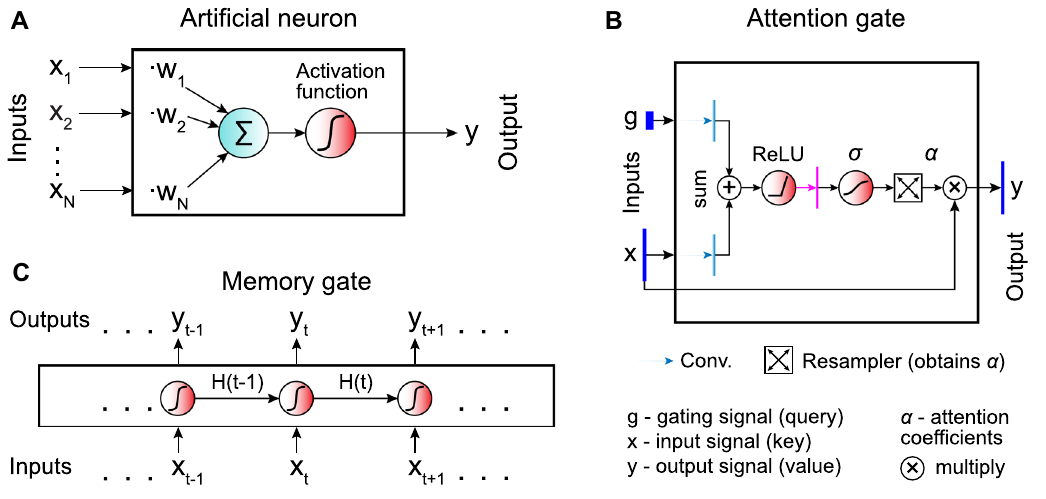
Figure 1: Building blocks of artificial neural networks.